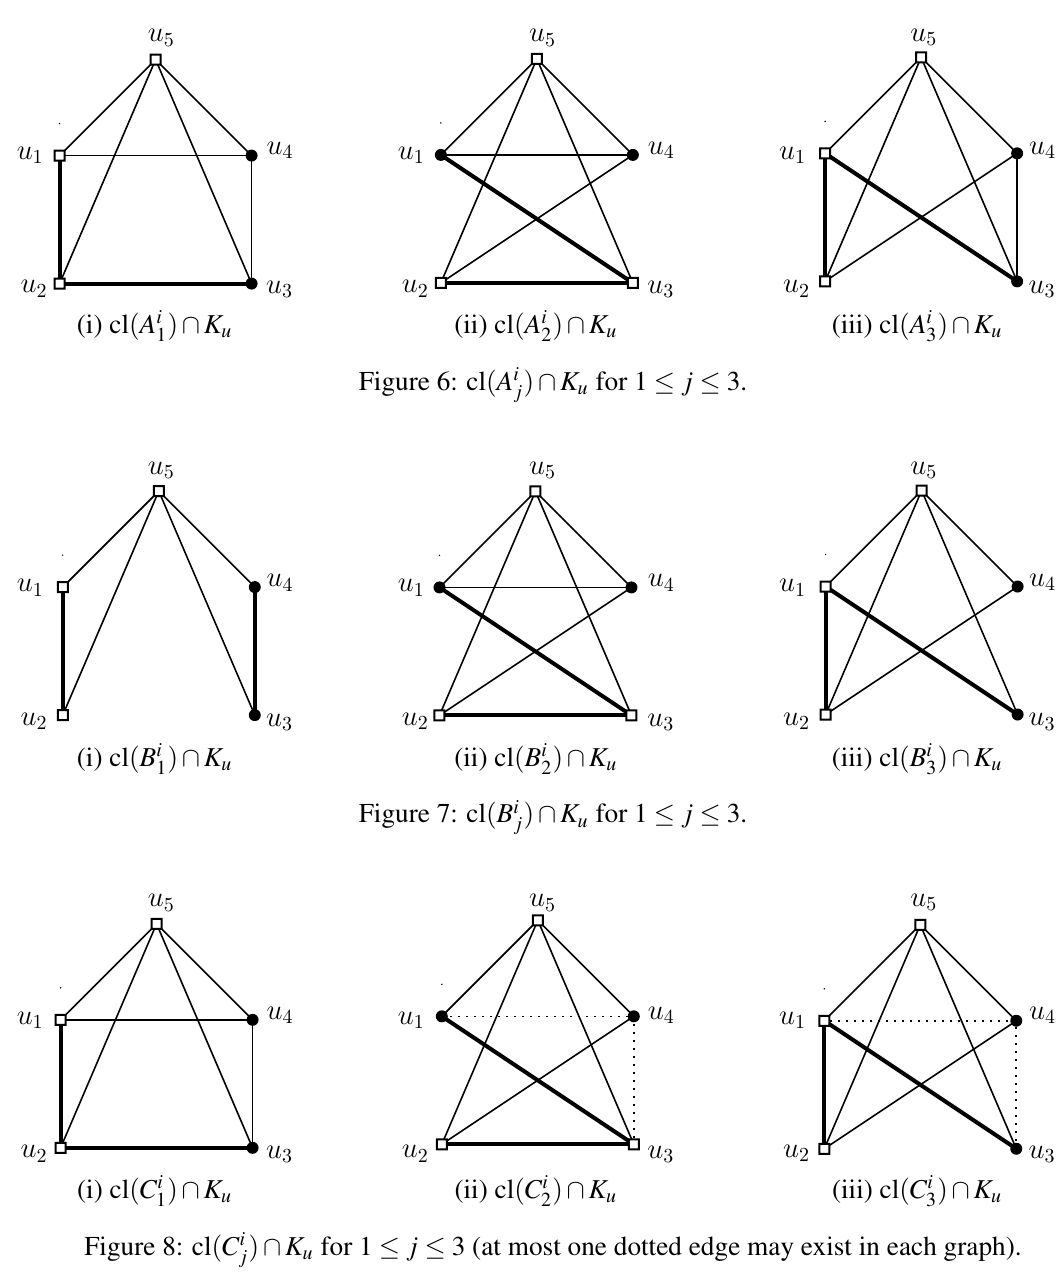
) ∩ K u for 1 ≤ j ≤ 3 (at most one dotted edge may exist in each graph). Figure 8: cl ( C i j